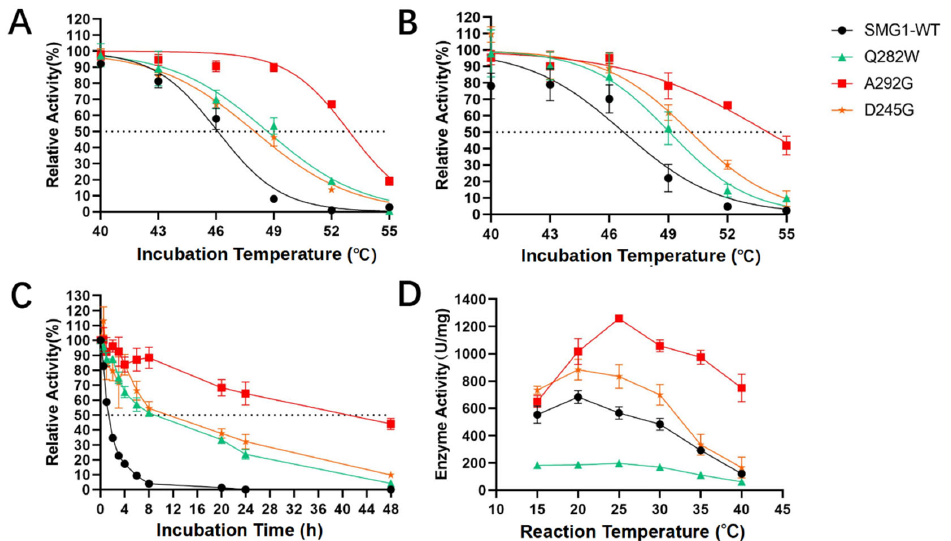
Figure 3. Characterization of purified proteins. ( A ) T 5015 was determined for the purified enzymes using 4-nitrophenyl caprylate. ( B ) T 5015 was determined for the purified enzymes using diacylglyc- erols. In both ( A , B ), purified enzymes were incubated at specific temperatures between 40–55 ◦ C in a 20 mM sodium phosphate buffer (pH 7.0) for 15 min and assayed for residual activities at 24 ◦ C. The activity of each enzyme (WT or mutants) measured at 24 ◦ C without exposure to the heat treatment was considered as 100%. The T 5015 value was determined using the inflection point of a sigmoidal fit of residual activities. ( C ) Kinetic thermostability of selected SMG1 mutants at 45 ◦ C. Purified enzymes were incubated at 45 ◦ C and pH 7.0 for up to 180 min. Residual activities were determined for samples withdrawn at specific time points. The activity of each enzyme without exposure to 45 ◦ C was defined as 100%. ( D ) The optimal reaction temperature for the WT and selected mutants. Purified enzymes were added to DAG substrates preincubated at specific temperatures and allowed to catalyze. The enzymatic unit was defined as the amount of enzymes required to produce 1 µ mol of fatty acids per minute. Each point represents the average of three independent experiments, with the error bar indicating their standard